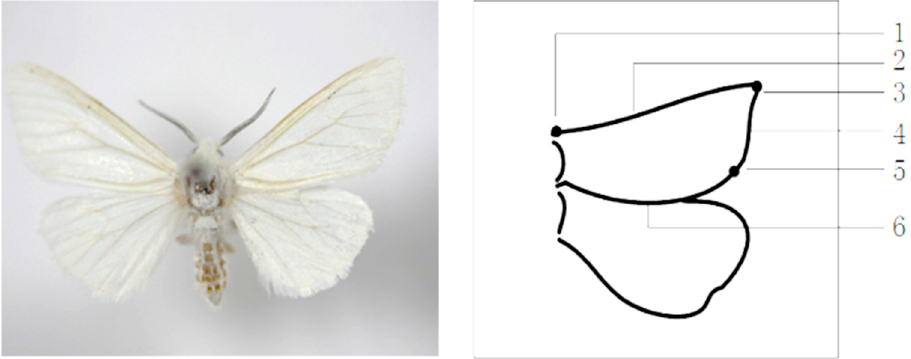
Figure 2. H. cunea and the outline of its wings. 1. Point of the humeral angle 2. Costal margin 3. Point of the apical angle 4. Outer margin 5. Point of the anal angle 6. Inner margin.